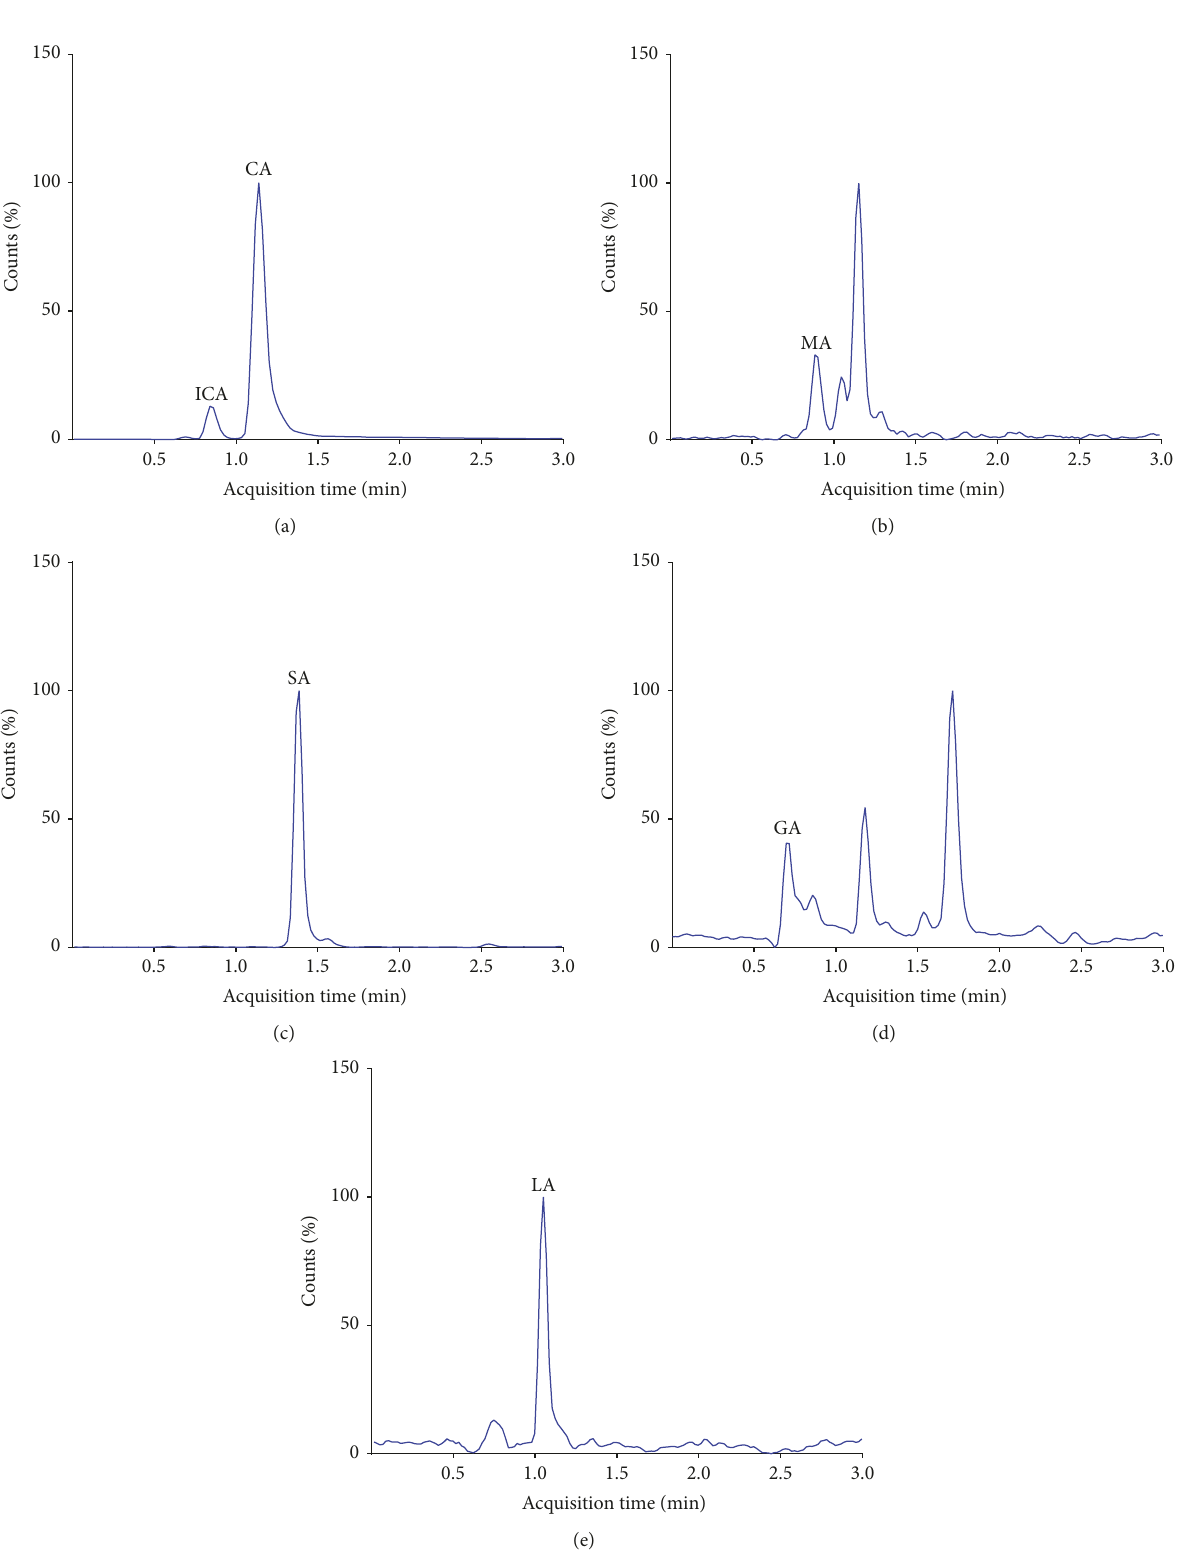
Figure 3: LC-MS/MS chromatograms of TCA cycle intermediates in human urine. (a) Citric (CA) and isocitric (ICA) acids; (b) malic acid (MA); (c) succinic acid (SA); (d) glutamic acid (GA); (e) lactic acid